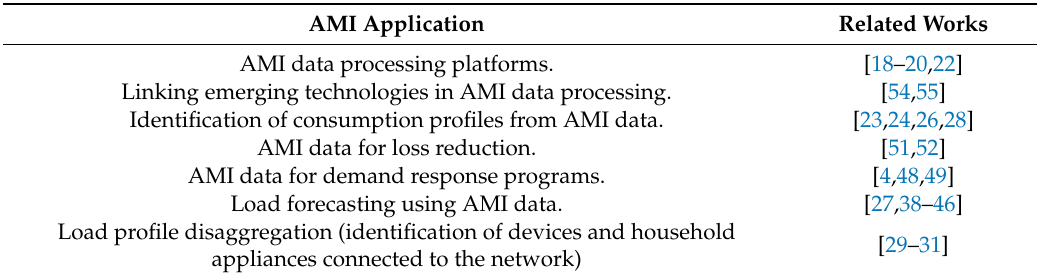
Table 1. Works on Advanced Metering Infrastructure (AMI) data